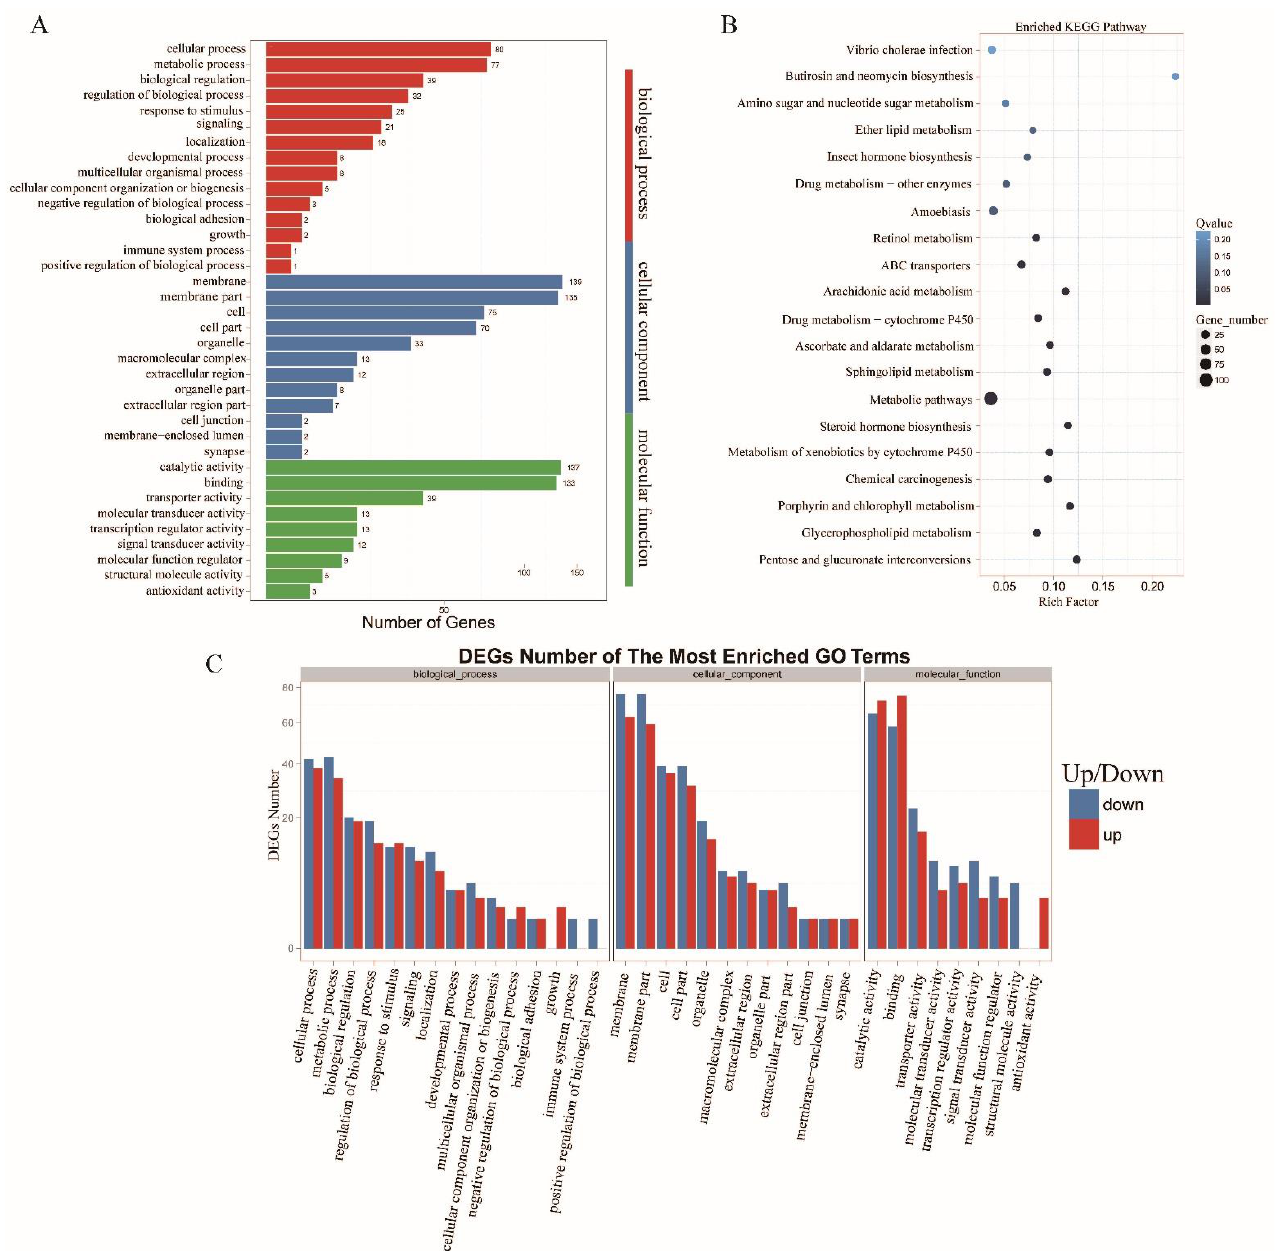
Figure 6. Statistical results from the GO enrichment, the Y-axis corresponds to the GO terms, the red histogram refers to biological processes, the blue is the cellular components, and green is molecular functions ( A ); KEGG pathways ( B ); and up- and down-regulated GO terms, where the X-axis indicates the different GO terms, down-regulation is shown in blue, and up-regulation is shown in red ( C ) of significant differential target mRNAs in Tribolium castaneum.